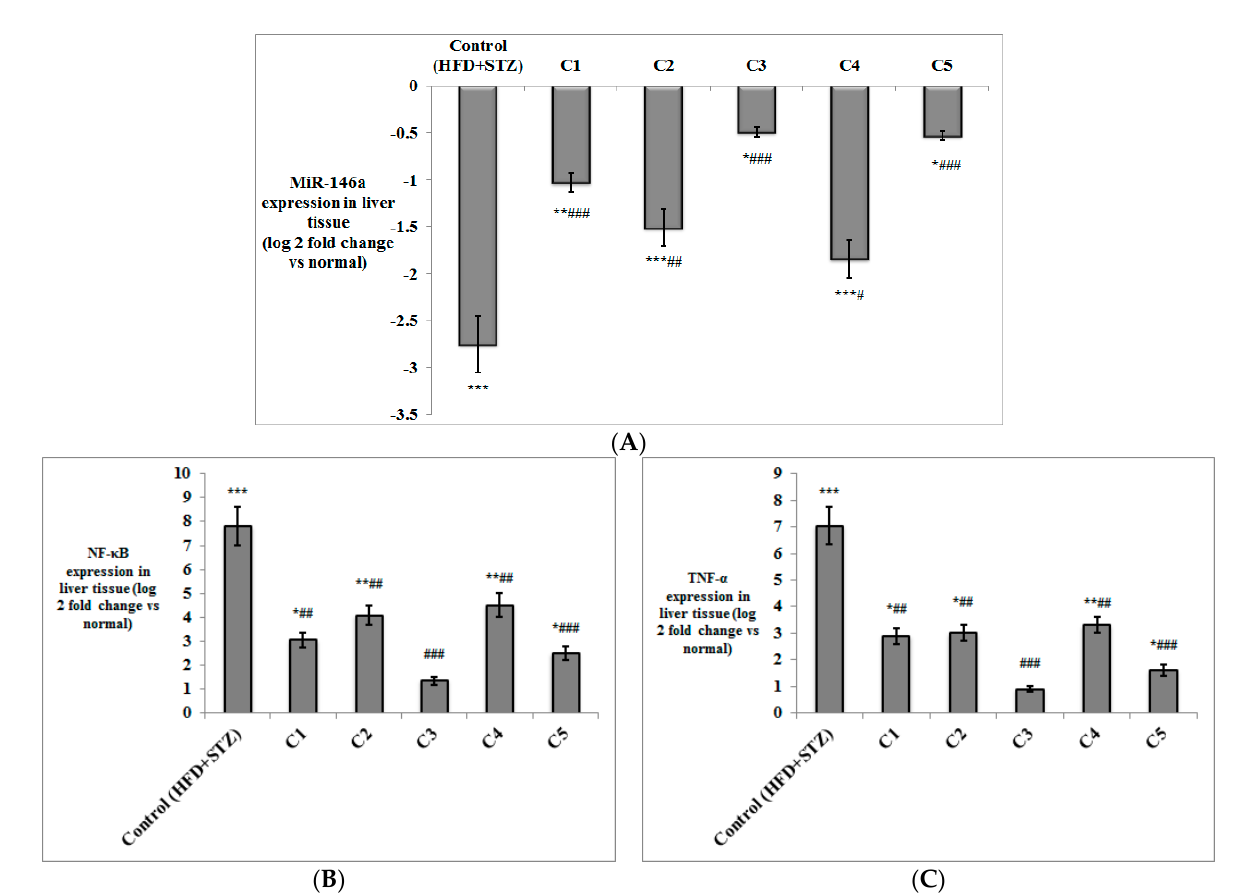
Figure 4. The effect of the isolated compounds on the expression of ( A ) miR-146a, ( B ) NF- κ B, ( C ) TNF- α in the liver tissue of the experimental rats. ( n = 6–8). NF- κ B = nuclear factor kappa B; TNF- α = tumor necrosis factor-alpha. C1: Rutin; C2: Quercetin 3- O -neohesperdoside; C3: Quercetin-3- O - β -galactoside; C4: Isoquercetin; C5: Quercetin. Data are expressed as mean ± SD of the log 2 fold change relative to the normal group (log 2 (1) = zero, i.e., base line). Statistical significance in relation to the normal group was assigned at * p < 0.05; ** p < 0.01; and *** p < 0.001, whereas statistical significance in relation to the T2DM control group (high fat diet + Streptozotocin) was assigned at # p < 0.05; ## p < 0.01; and ### p < 0.001 using one-way ANOVA followed by Bonferroni’s post hoc test.